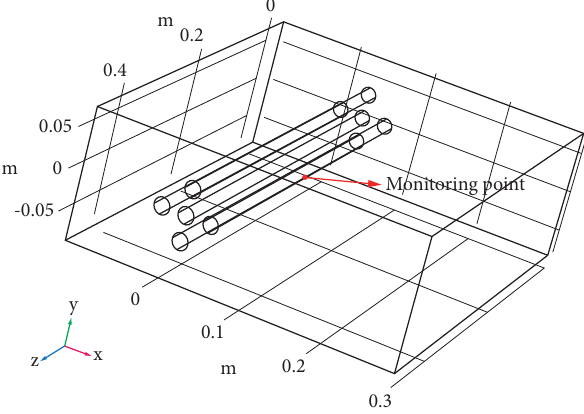
Figure 23: Location map of monitoring points.